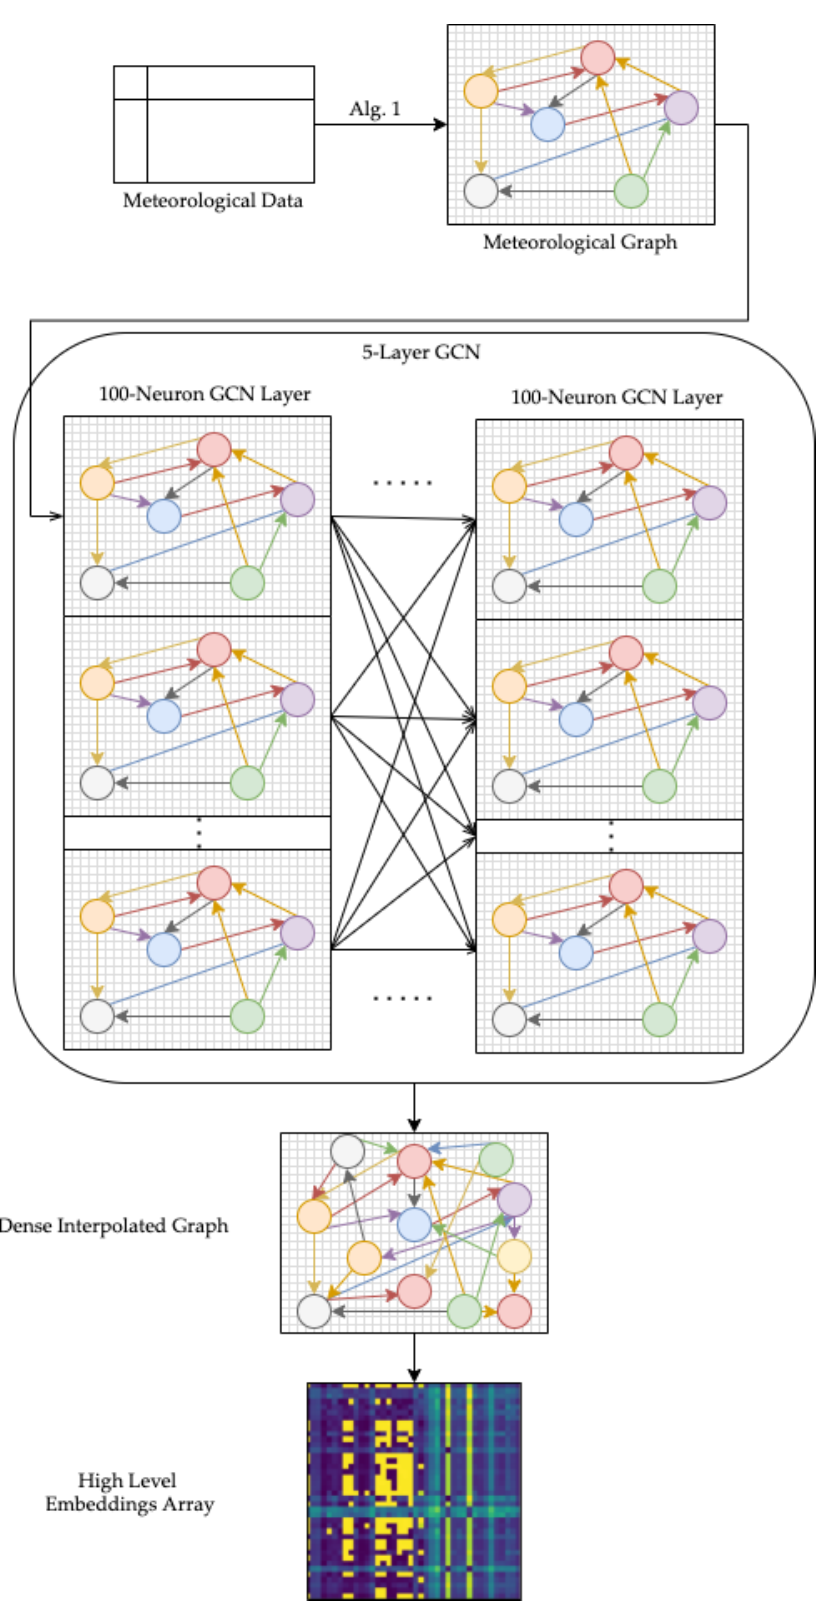
Figure 2. Visualization of GCN module of our model architecture applied to meteorological